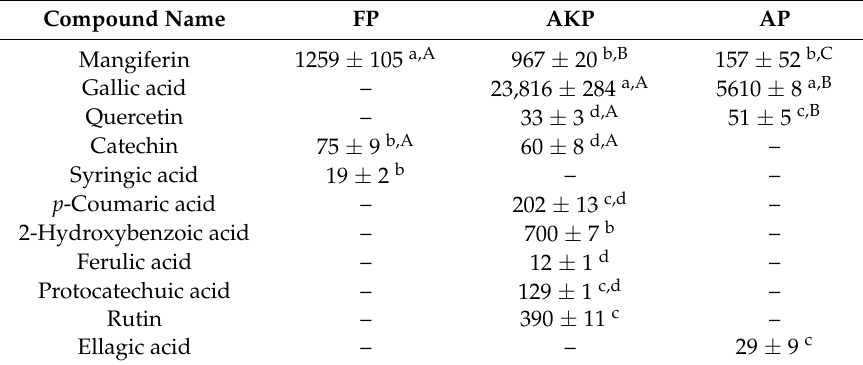
Table 1. Monomeric polyphenols ( µ g/g dry weight) in ‘Ataulfo’ mango peel extracts. Compound Name